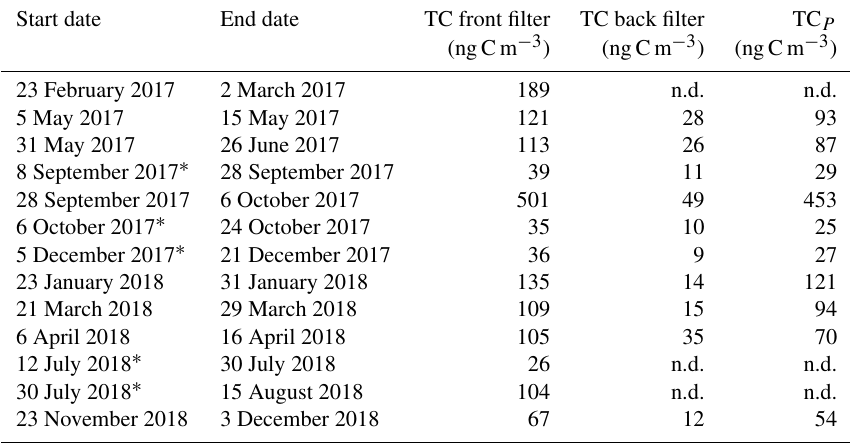
Table 3. Filter loadings and fractions for front and back filters for TC measured at the University of